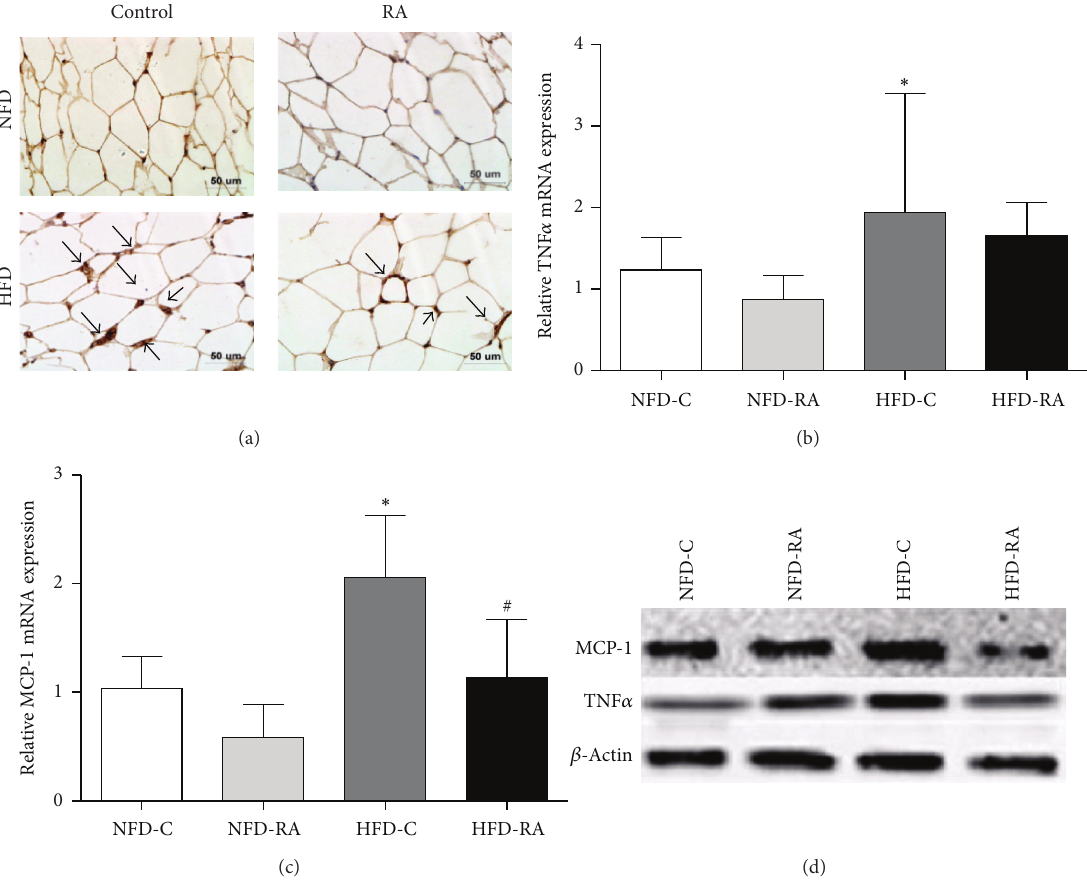
Figure 3: RA treatment improves the inflammatory state in intra-abdominal white adipose tissue. (a) Immunohistochemical staining of epididymal adipose tissue with anti-F4/80 antibodies. qRT-PCR analysis of TNF 𝛼 (b) and MCP-1 (c) in the epididymal fat pad. ∗ 𝑃 < 0.05 (HFD-C group versus NFD-C group) and # 𝑃 < 0.05 (HFD-RA group versus HFD-C group). (d) Protein levels of MCP-1 and TNF 𝛼 in the epididymal fat pad.